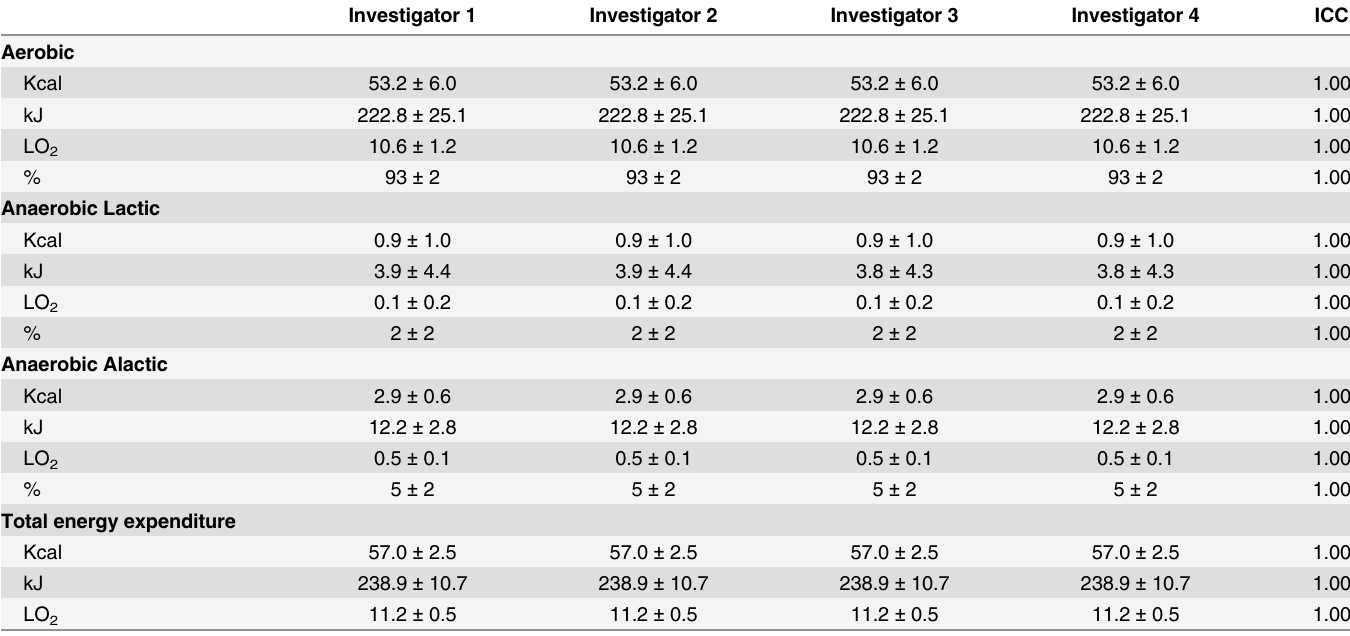
Table 4. Intra-investigator variation for energy expenditure amount and energy system contribution estimated at moderate domain (n = 11).